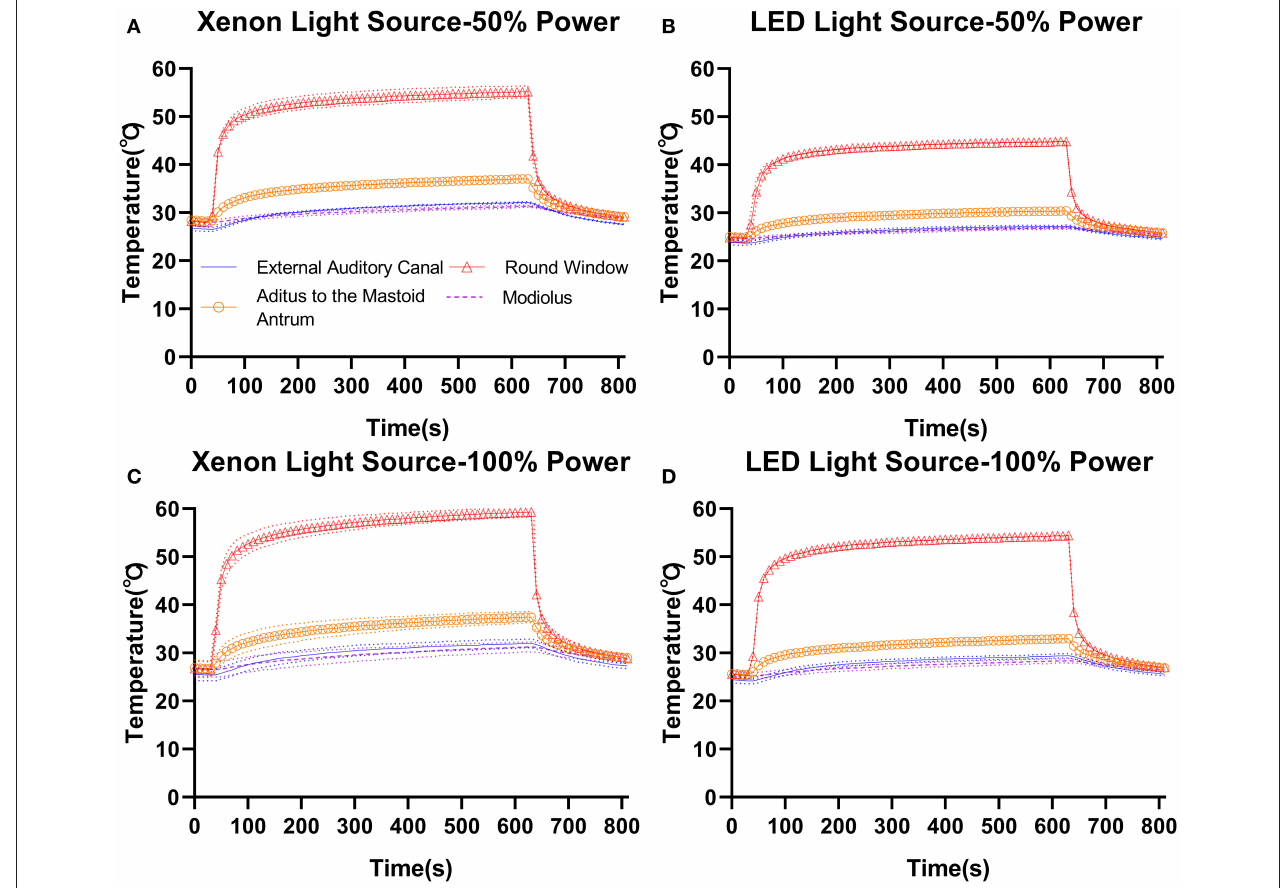
FIGURE 3 | Temperature elevation in temporal bone (4R) with the Neuro-0 endoscope under different xenon (A,C) and LED (B,D) light source power